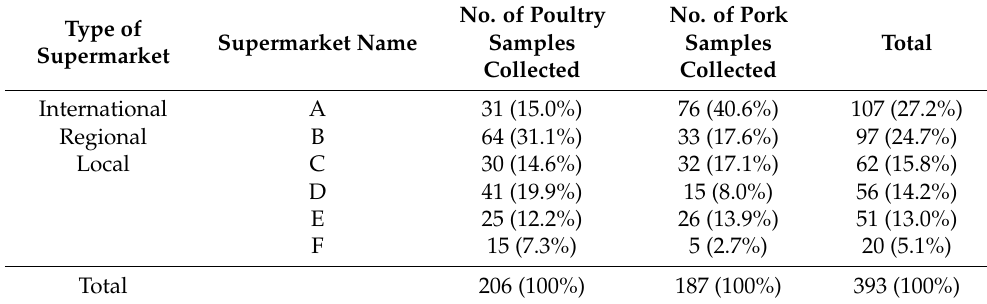
Table 1. Table showing the sample distribution across the selected retailing outlets in Kenya. No. of Type of Supermarket Name Supermarket